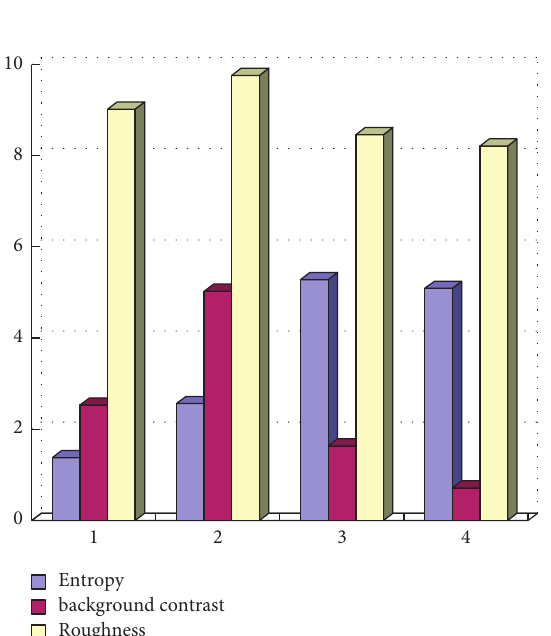
Figure 9: Comparison of the source image and the average weighted